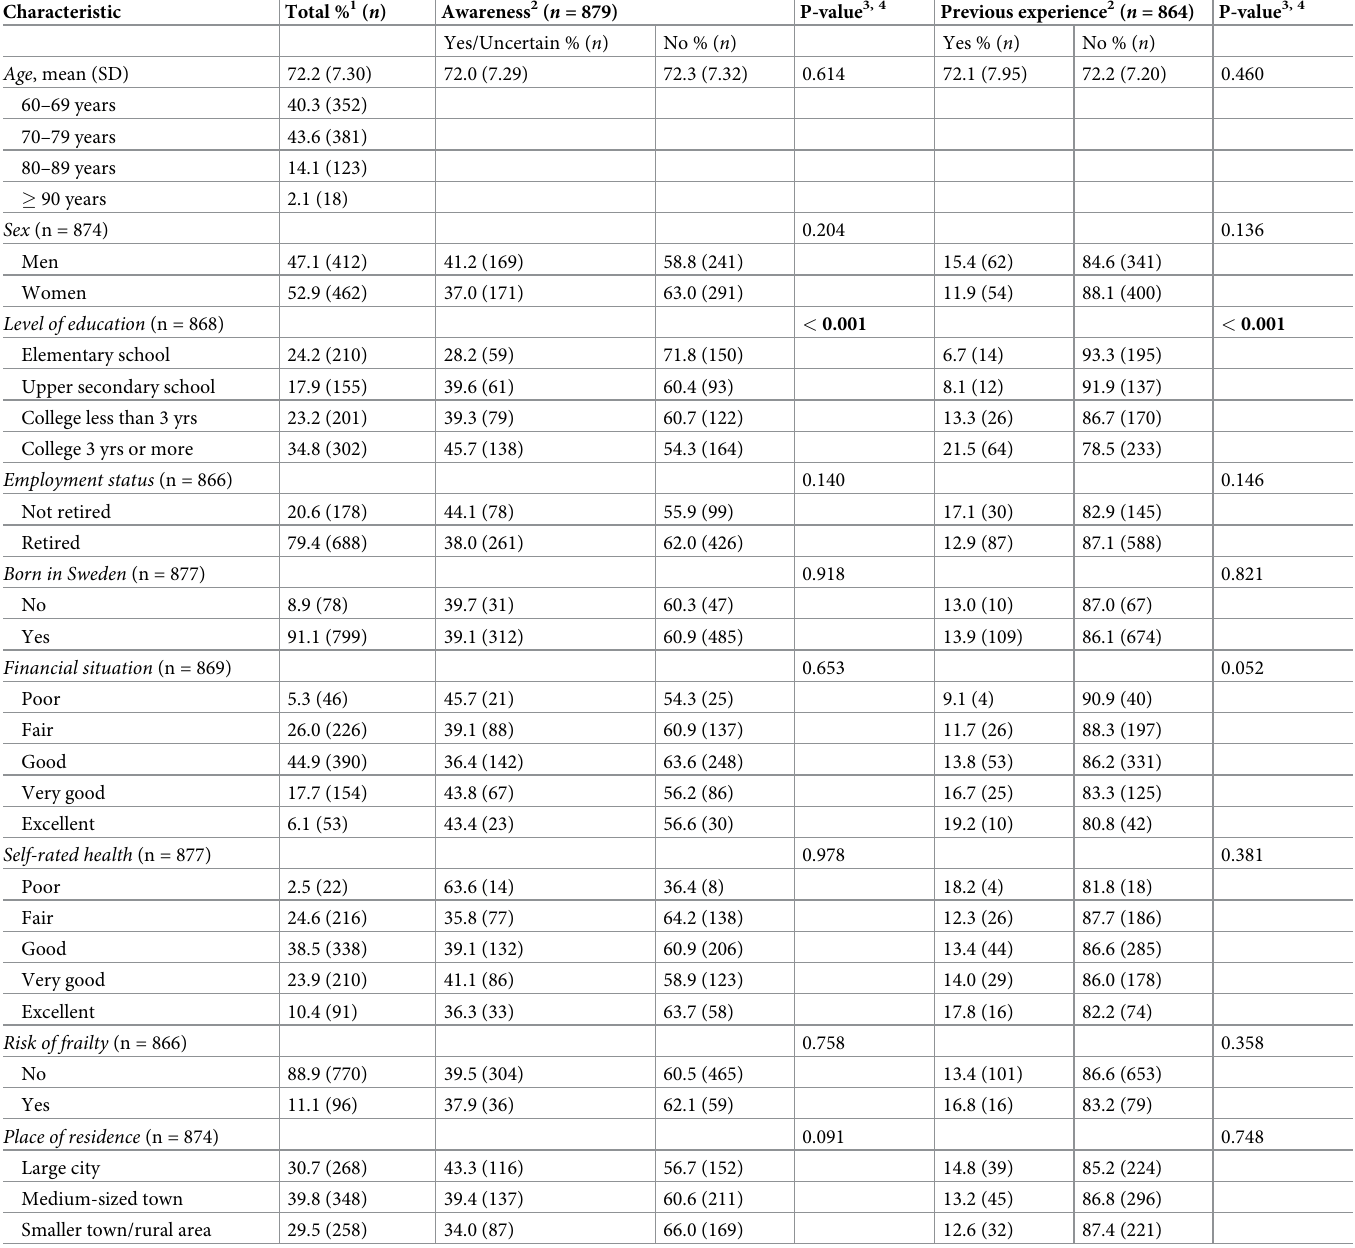
Table 1. Respondent characteristics and characteristics related to respondents’ awareness of the possibility to be actively involved in research on ageing and previ- ous experience of being actively involved in research.